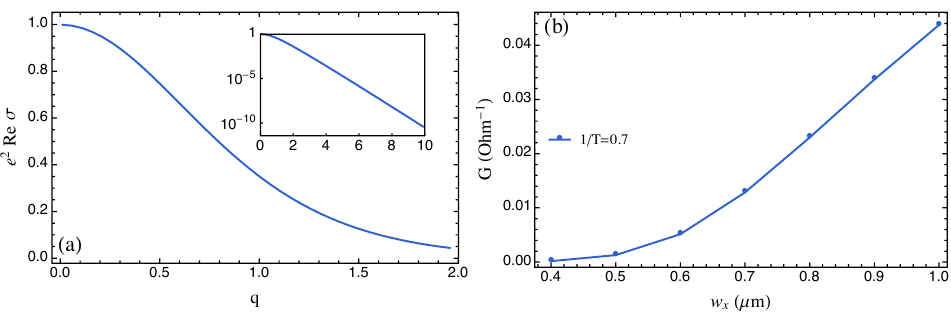
Figure 7: Spectral weight and conductance at zero density. (a): momentum depen- dence of spectral weight of current. Inset shows the exponential decay of the spec- tral weight with respect to q . (b): Numerical result matches the heuristic argument ) at w < 1 / T (see G ∼ σ ( k = 1 / w x x